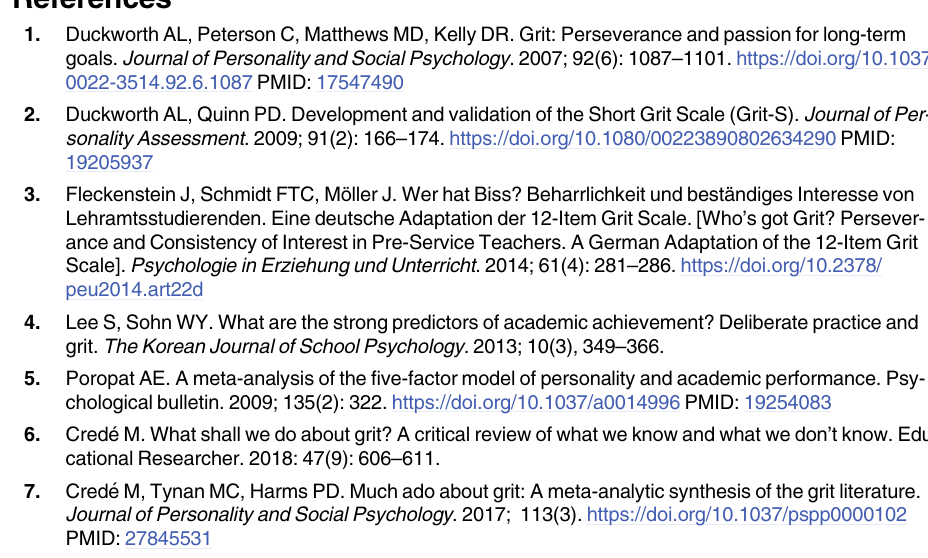
S3 Table. Descriptive statistics and correlations between the external criteria used in this study. � p < .05, �� p < .001. Gf = Fluid intelligence. Gc = Crystallized intelligence. LS = Life sat-